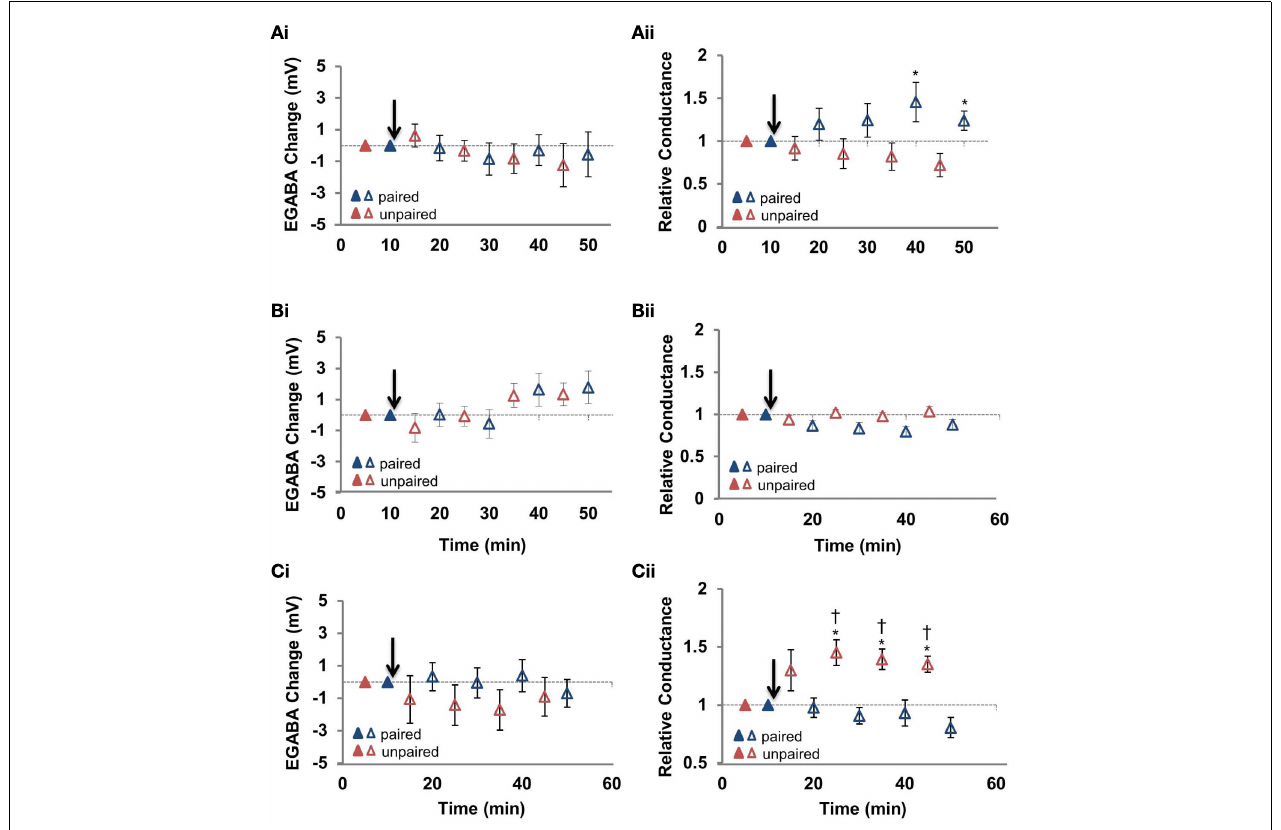
FIGURE 5 | N -methyl-D-aspartic acid receptor blockade withAPV spares the increased GABAergic conductance at the unpaired pathway. (Ai) Summary of the change in E GABA at the paired and unpaired pathways induced in the presence of cell-loaded BAPTA to chelate Ca 2 + ( n = 5). (Aii) Summary of the change in relative GABAergic conductance at the paired and unpaired pathways for all cells in (Ai) . (Bi) Summary of the change in E GABA at the paired and unpaired pathways induced in the presence of bath applied nimodipine to block L-type Ca 2 + channels (15 μ M applied for the duration of the recording; n = 5). (Bii) Summary of the change in relative GABAergic conductance at the paired and unpaired pathways for all cells in (Bi) . (Ci) Summary of the change in E GABA at the paired and unpaired pathways in the